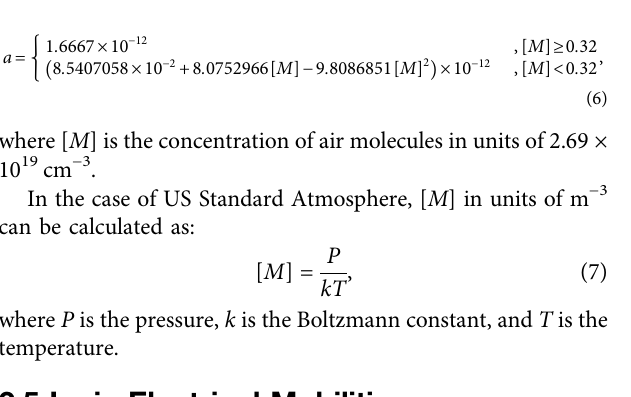
FIGURE 2 | Quantities used in the interpolation formulas for the ionization rate calculation, as functions of the geomagnetic latitude: (A) q , and (B) z i .